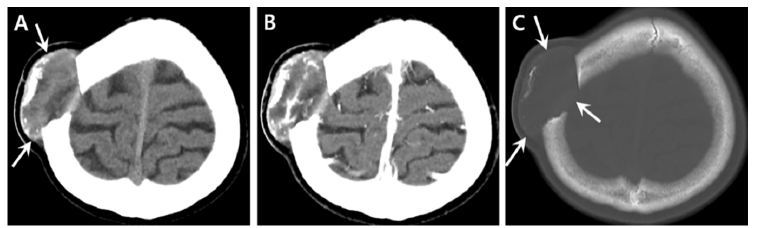
Figure 1. Frontal ( A ) and lateral ( B ) skull radiographs showing a well-circumscribed, oval, osteolytic lesion in the right parietal bone (arrows) with incomplete marginal sclerosis and overlying scalp swelling.